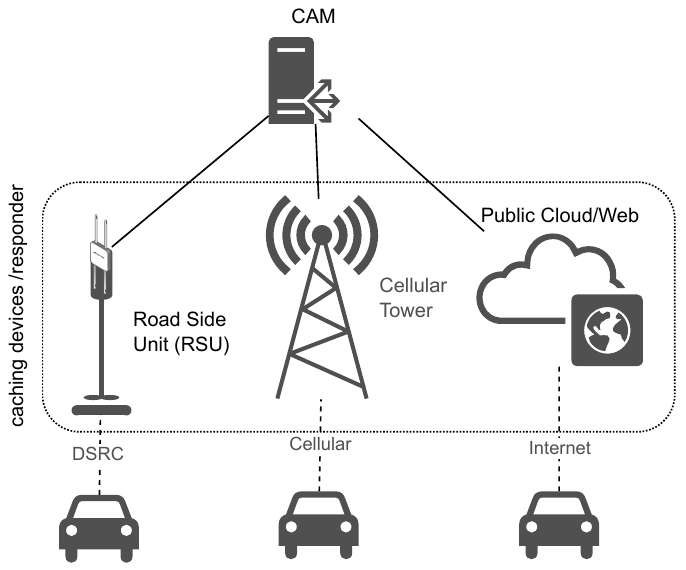
Figure 6. Caching strategy